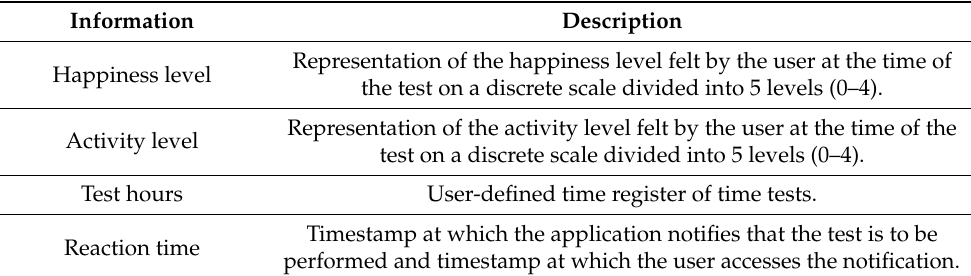
Table 11. Information collected by the application. Information